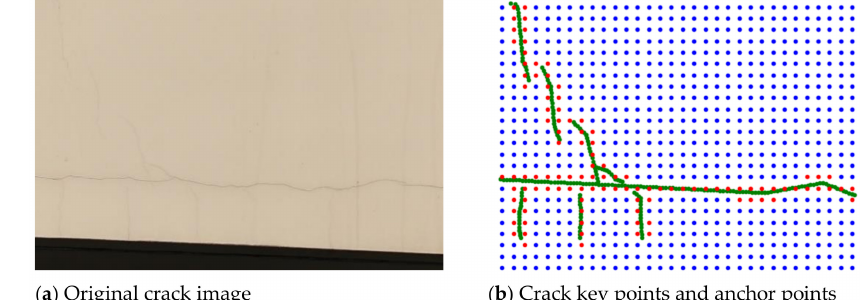
Figure 5. Positive and negative sample